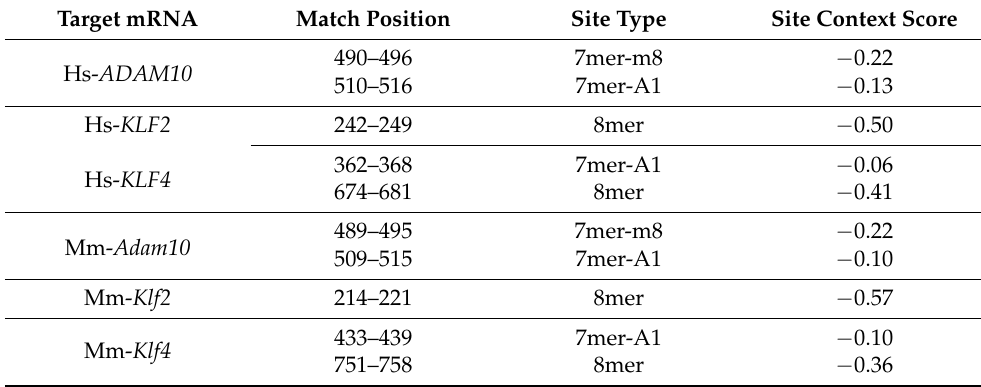
Table 1. Analysis results of miR-92a downstream targets by